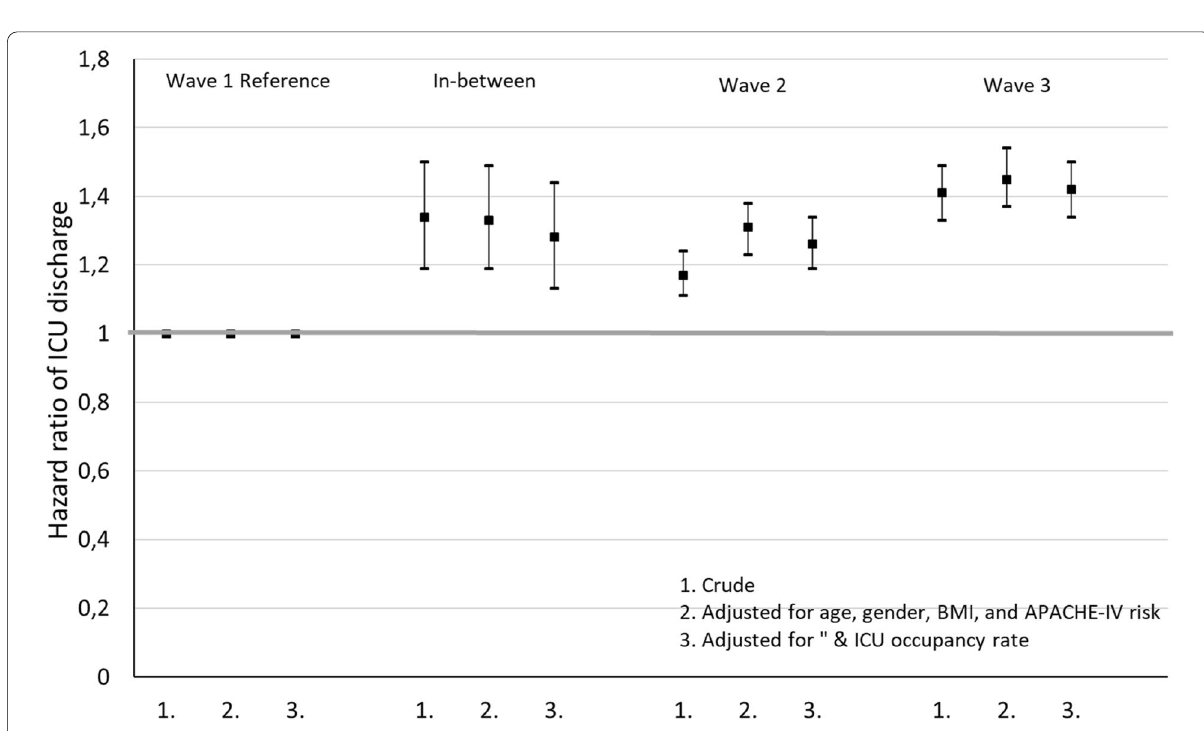
Fig. 3 Crude and adjusted Cox regression showing Hazard ratios of ICU discharge during Wave 2 and Wave 3, and the period in‑between compared to Wave 1 (see Additional file 1: Table S3, death as censoring event). A Hazard ratio of ICU discharge higher than 1.00 implies a comparatively